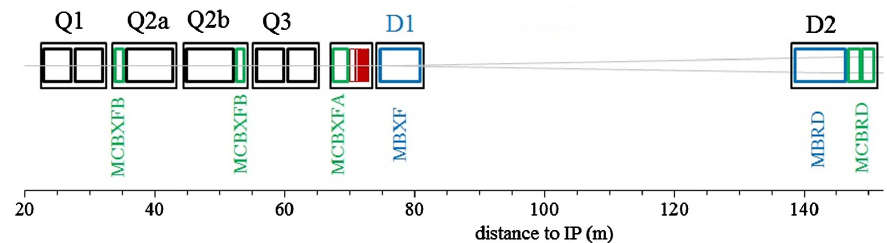
1. The new layout of the right side of the region close to Point 1 and Point 5 foreseen for the HL-LHC. The experiment is on the left side of the figure (not shown) and the rest of the ring continues on the right. The left side of the layout is symmetric with respect to the interaction point.